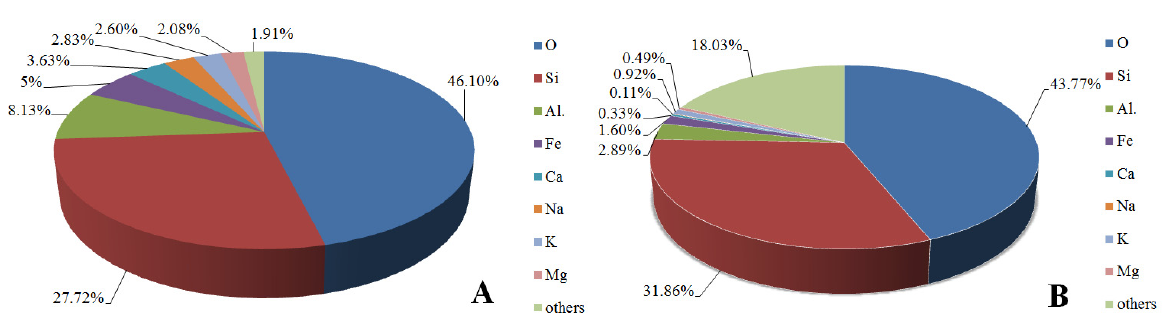
Figure 1. Elemental composition of Earth crust ( A ) and diatom frustule ( B ).